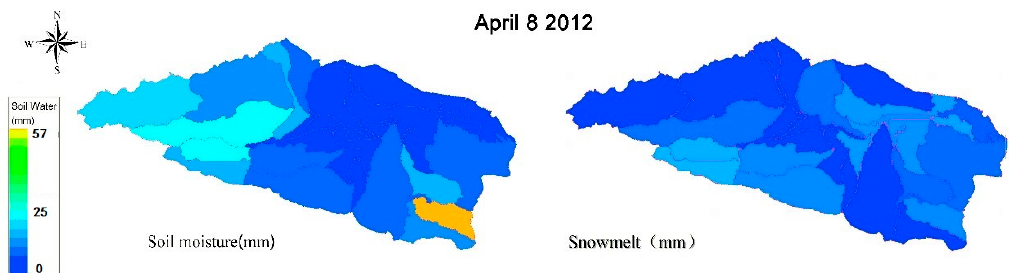
Figure 11. Spatial distribution of soil moisture and snowmelt rateof the JBR.